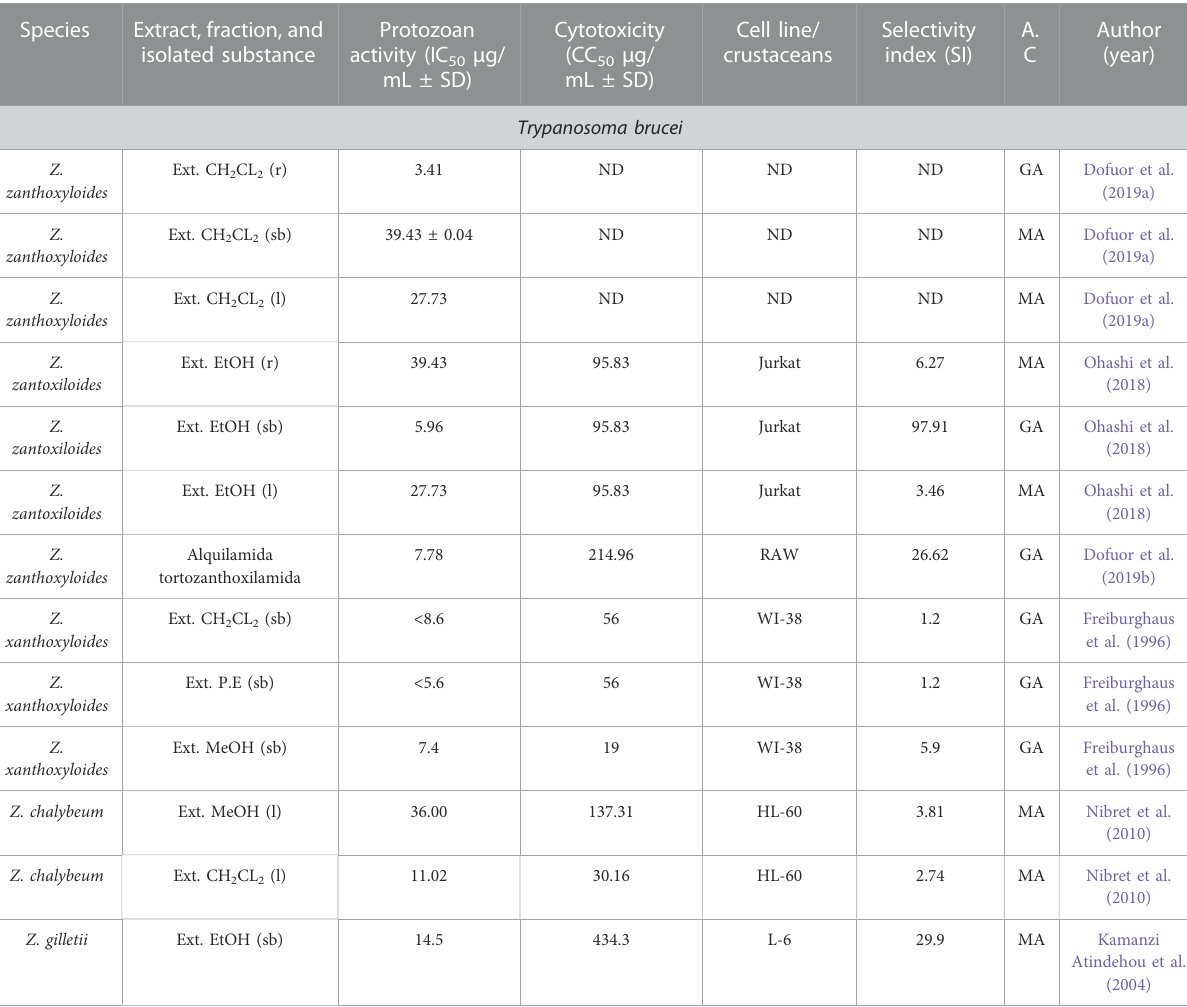
TABLE 9 In vitro antiparasitic activity against Trypanosoma brucei . Species Extract, fraction, and isolated